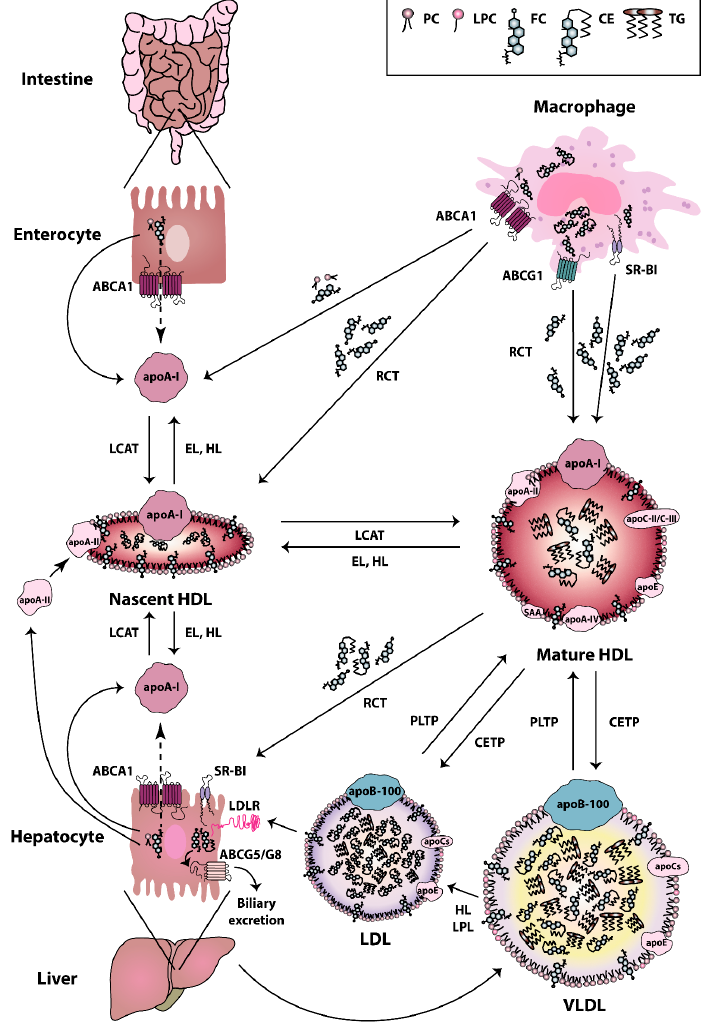
Figure 1. High-density lipoprotein (HDL) metabolism. HDL metabolism is a multistep process involving (i) the secretion of lipid-free apolipoproteins by the liver or intestine, (ii) the acquisition of cholesterol and phospholipids via ATP-binding cassette (ABC) transporter A1 (ABCA1), ABCG1, and scavenger receptor class B type I (SR-BI), (iii) the maturation by lecithin cholesterol acyltransferase (LCAT)-mediated cholesterol esterification and (iv) the final uptake of lipids by the liver. Cholesterol uptake is either mediated directly via SR-BI, or indirectly via cholesteryl-ester transfer protein (CETP)-mediated transfer of cholesteryl ester to very low-density lipoproteins (VLDL) and low-density lipoproteins (LDL) and uptake by the LDL-Receptor. The liver excretes then cholesterol into the bile, either directly via the action